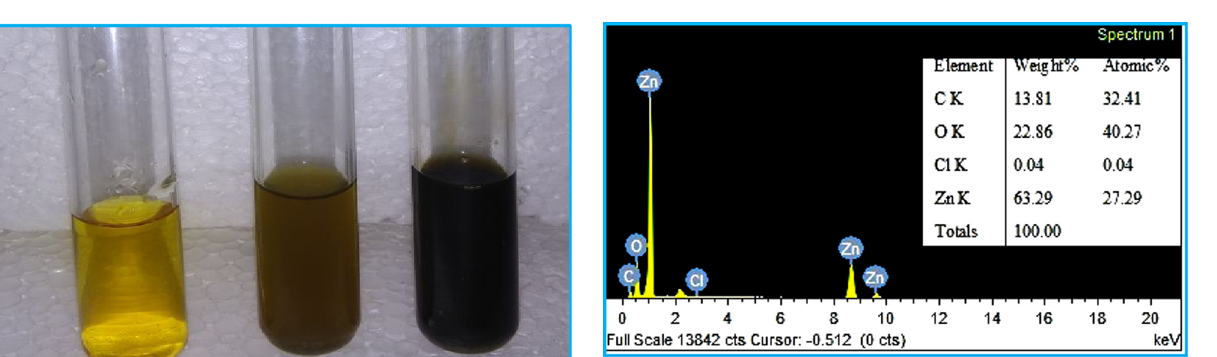
Figure 2: Biosynthesis of zinc oxide nanoparticles from methanol leaf extract of C. baccifera.